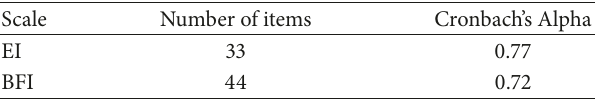
Table 6: Linear regression analysis indicating neuroticism as the predictor of EI ( 𝑁 = 100 ).